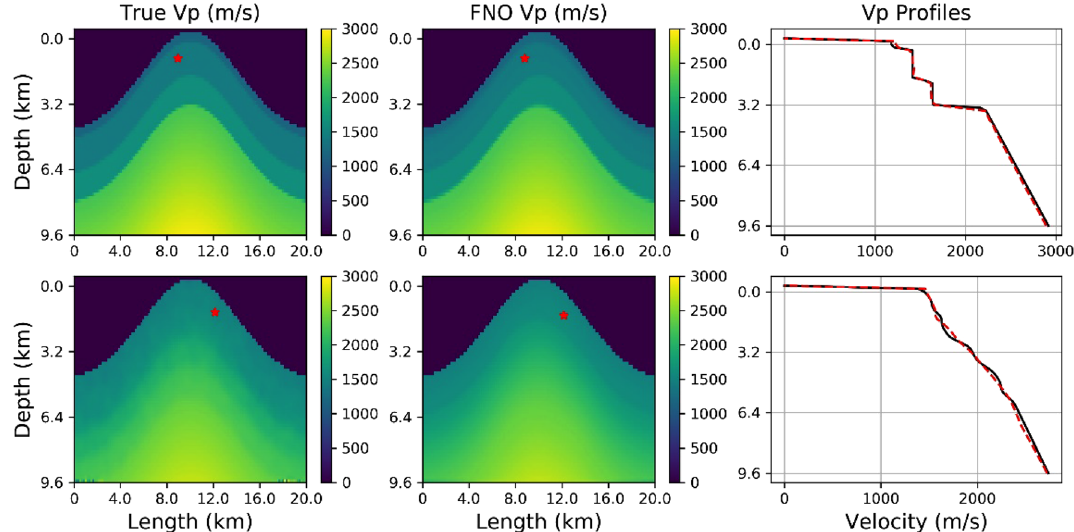
Figure 6. Left panels, the true unseen models velocity models (top panel from population L, bottom from population T) used to generate the input seismograms for the FNO network. Middle panels, the velocity model predictions (outputs from the FNO). Right panel, profiles through the true and predicted models. The seismic source location is highlighted by the asterisks. In the FNO output, the source location is also predicted by the network. Both velocity models here are each recovered from input data associated with only one randomly located shot into 10 randomly located surface receivers, each.